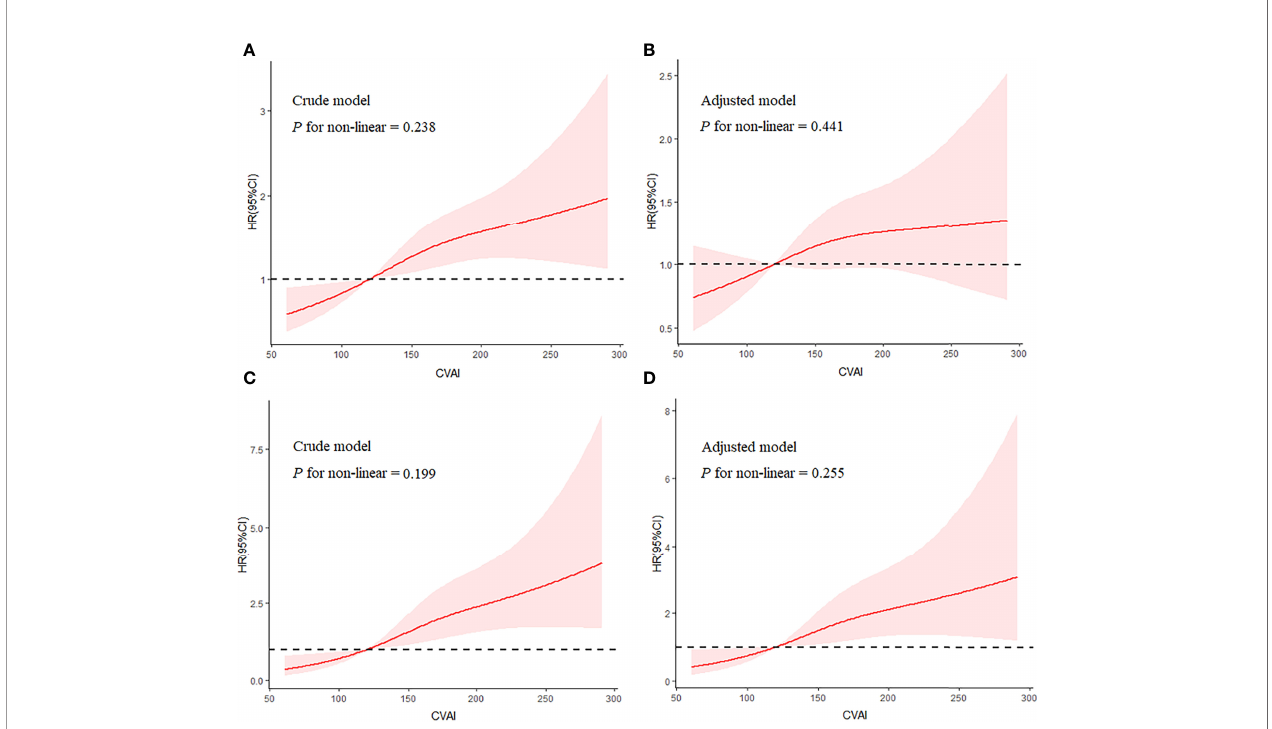
FIGURE 2 | Shape of the association of CVAI with renal damage (A, B) and overt renal damage (C, D) by restricted cubic spline. Adjusted model included variables of age, sex, smoking status, drinking status, SBP, baseline eGFR, duration of hypertension, types of GMD, glucose metabolism disorders; antidiabetic drugs, anti- hypertension drugs, HbA1c, BUN, and hyperuricemia. CVAI, Chinese visceral adiposity index; SBP, systolic blood pressure; eGFR, estimated glomerular fi ltration rate; HbA1c, glycosylated hemoglobin; BUN, blood urea